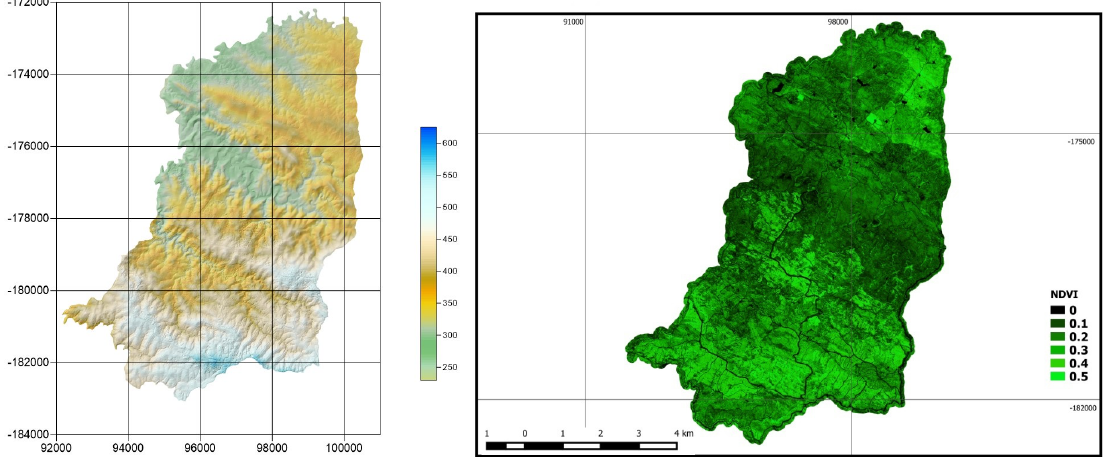
Figure 5. DEM and NDVI maps incorporated in the application.